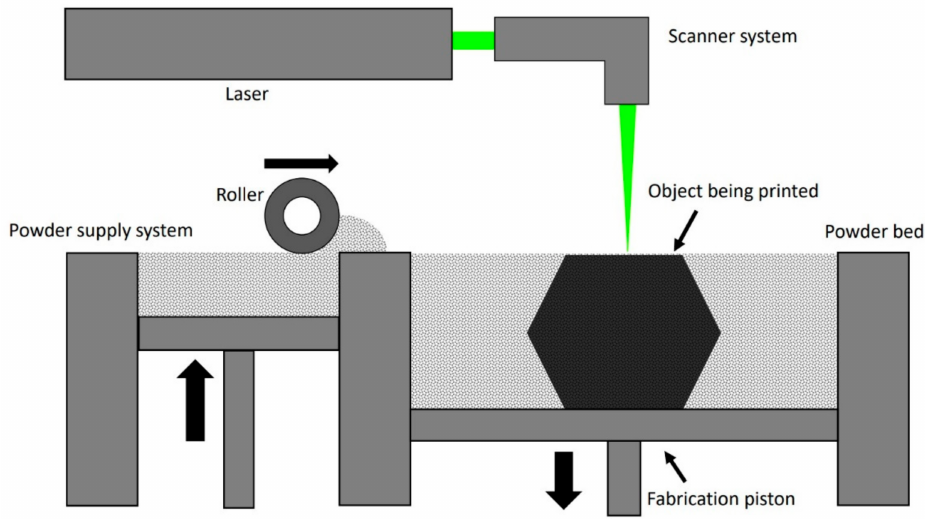
Figure 5. Scheme of SLM fabrication